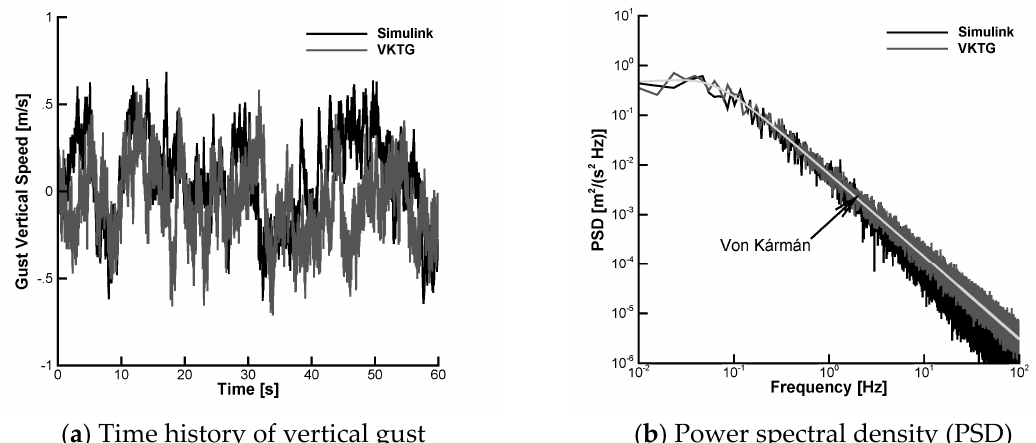
Figure 2. Random vertical gust intensity using the Von K á rm á n spectral representation (Military Specification: MIL-F-8785C; flight speed: U ∞ = 280 m/s; altitude: h = 10,000 m; and turbulence intensity: “light 10 − 2 ”; the terms “Simulink” and “VKTG” denote, respectively, the Von K á rm á n Wind Turbulence Model block of MATLAB and the present Von K á rm á n Turbulence Generator implementation.).